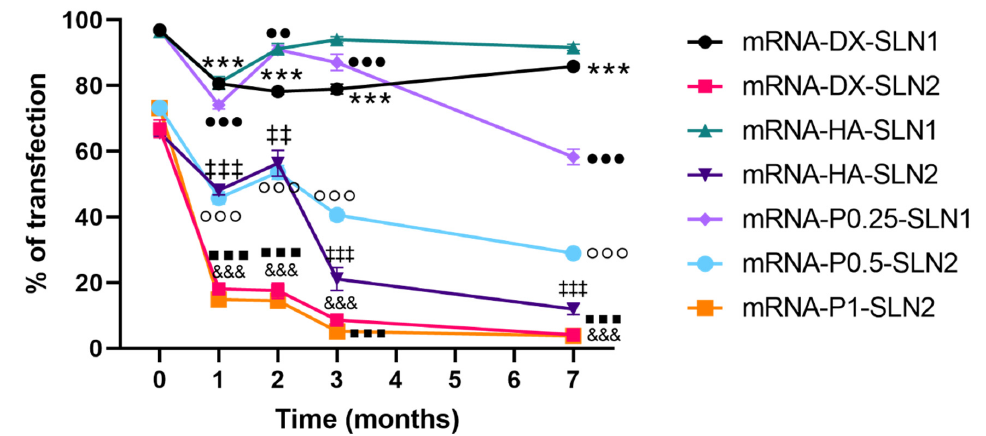
Figure 13. Percentage of ARPE-19 transfected cells after treatment with mRNA vectors after different times of storage. Data are expressed as mean ± standard deviation; n = 3. *** p < 0.001 with respect to mRNA-DX-SLN1 at time zero. &&& p < 0.001 with respect to mRNA-DX-SLN2 at time zero. ‡‡ p < 0.01,